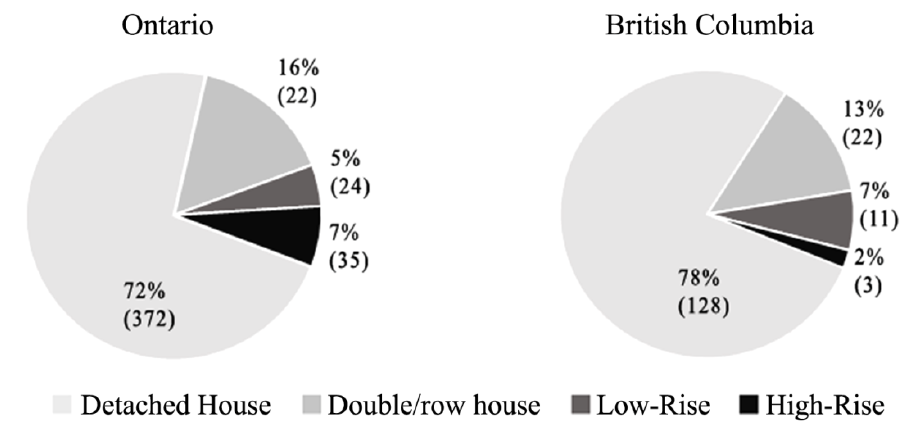
Figure 1. Total annual energy consumption of households in Ontario and BC (Million GJ)